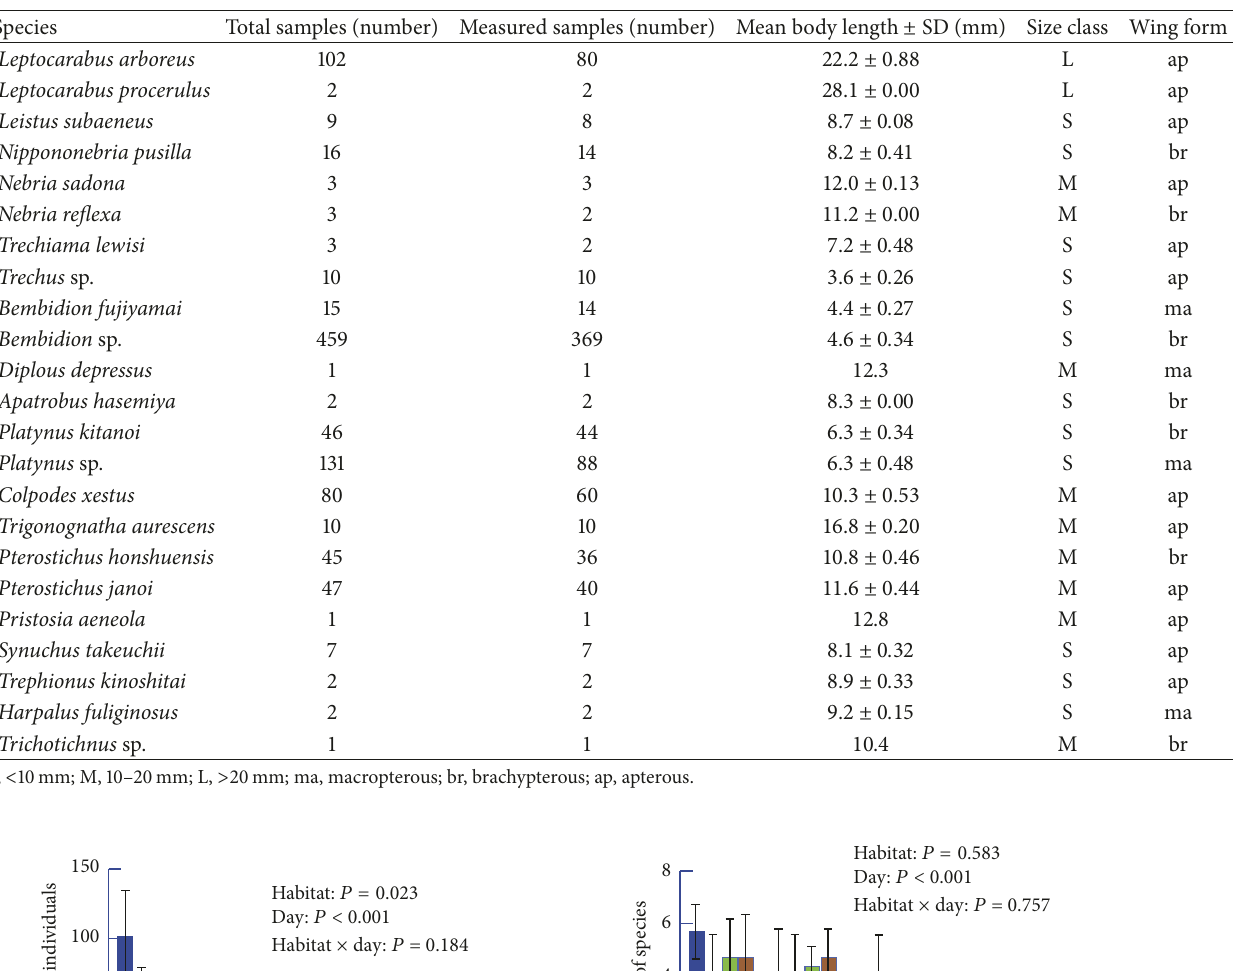
Table 1: Total and measured sample numbers, mean body lengths ( ± SDs), size classes, and wing forms of carabid beetles in the alpine- subalpine zone on Mt. Hakusan in central Japan.